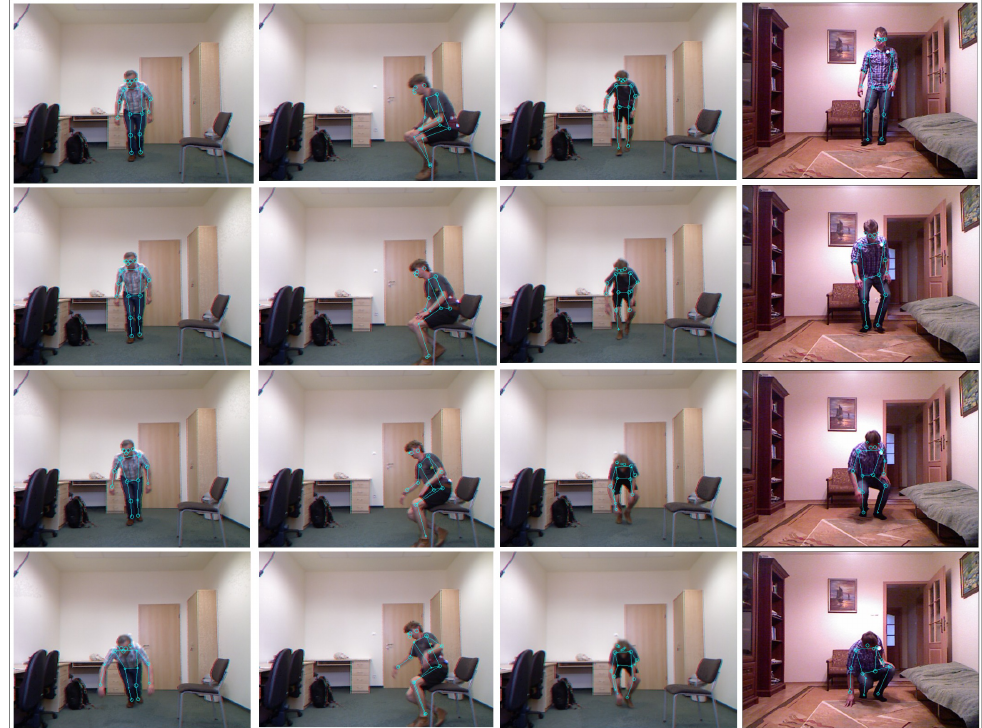
Figure 7. UR dataset: Skeleton detected with the V2V-PoseNet on some frames.